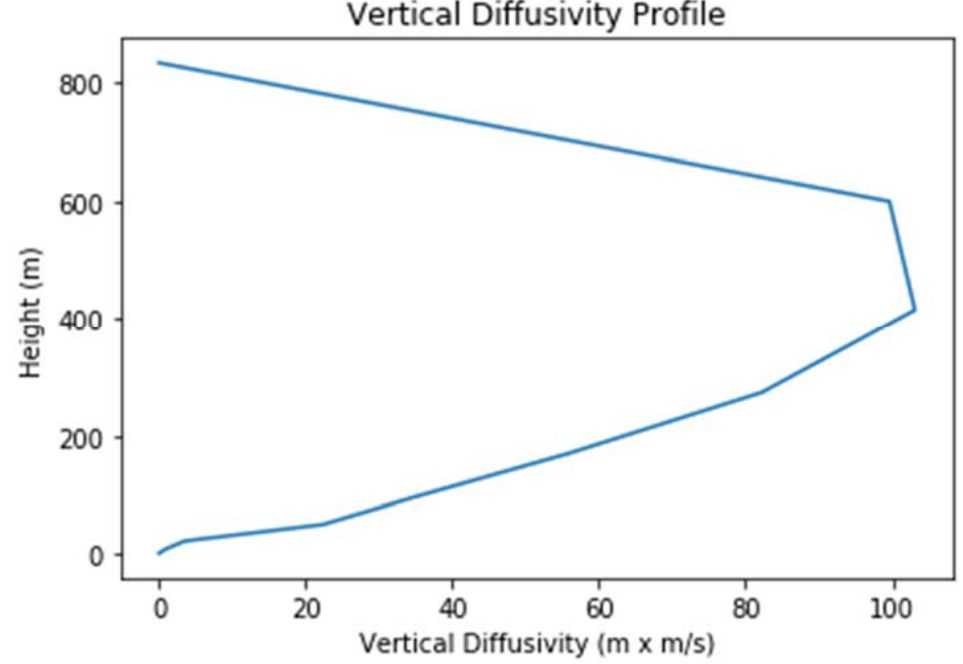
Figure 2. Profile of the vertical diffusivity used in the model simulations.